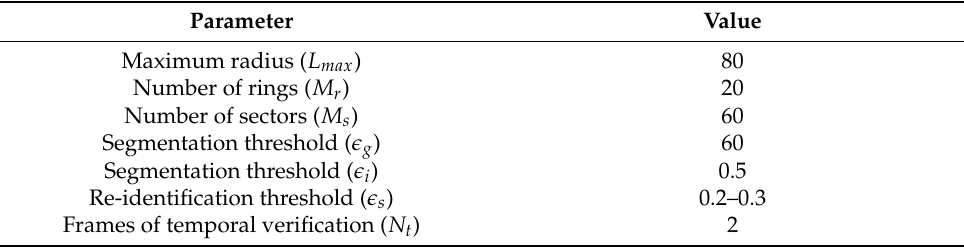
Table 1. Parameter